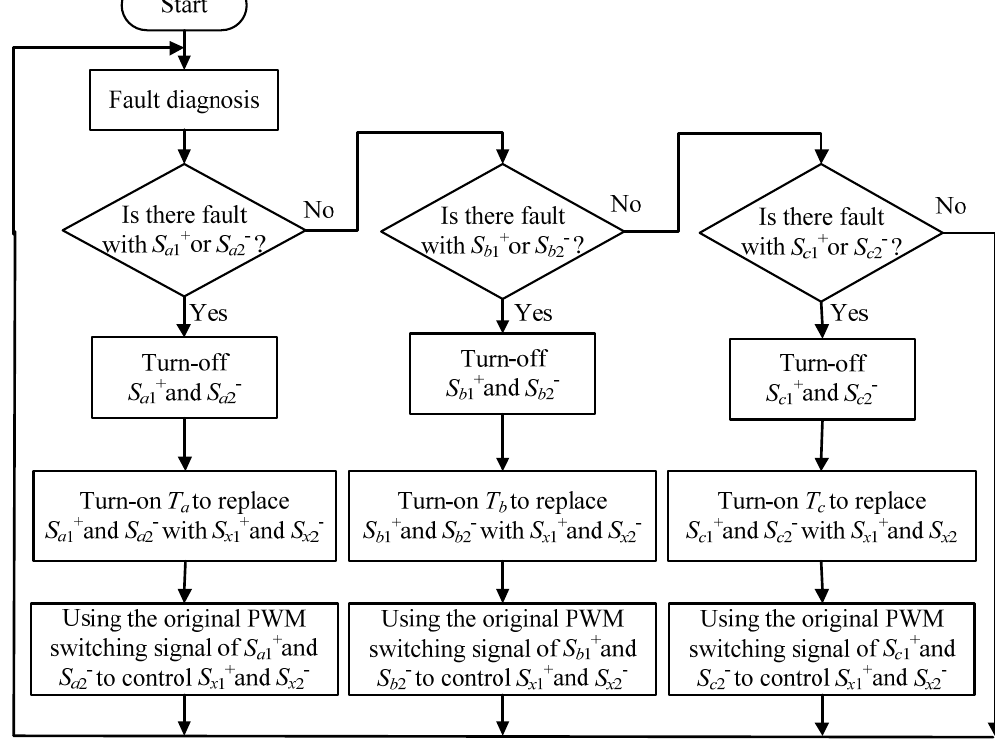
Figure 16. The flow chart of the proposed fault-tolerant control system in case of any power switch fault.